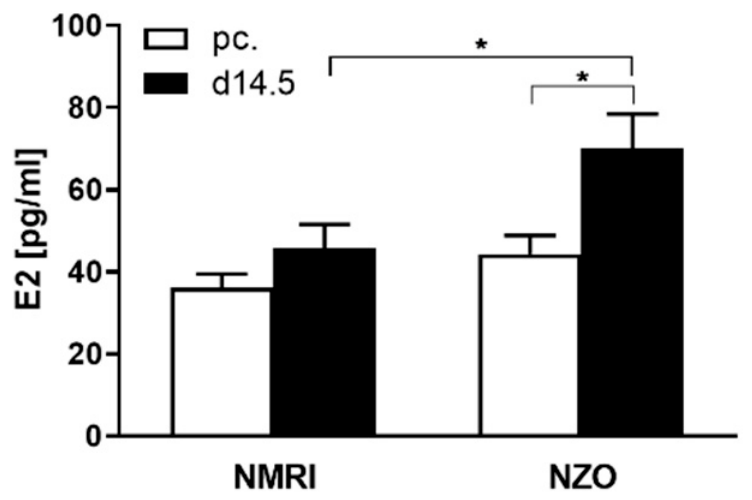
Figure 1. Elevated E2 levels in NZO mice during gestation. Plasma E2 concentrations in NMRI and NZO mice fed ad libitum at time points preconceptional (white bars) and d14.5 (black bars). Data are presented as means ± SEM (n = 6 animals per group). * p < 0.05.